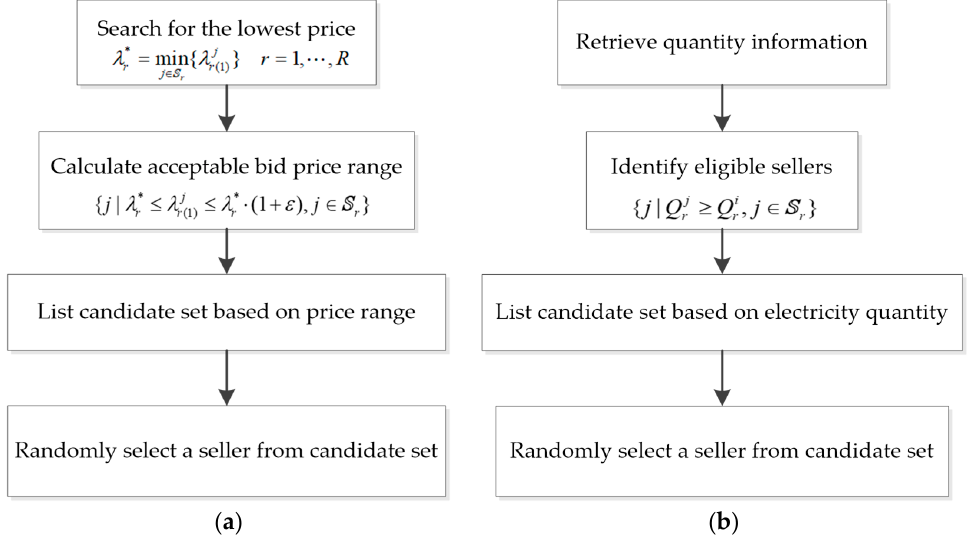
Figure 3. Two strategies of counterparty search: ( a ) Price-based search; ( b ) Quantity-based search. where